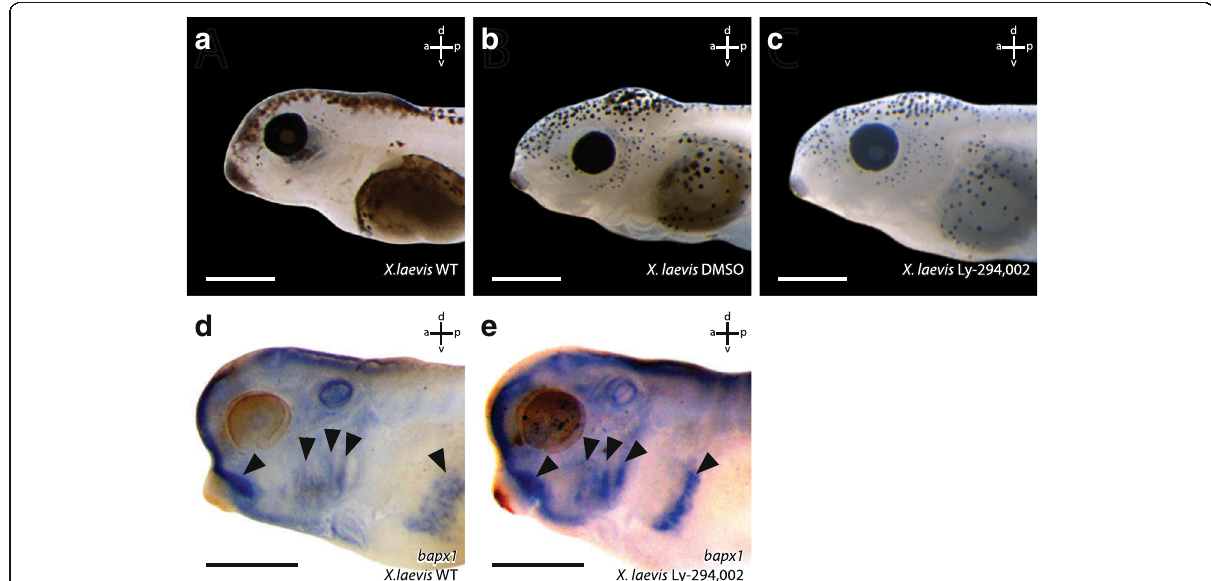
Fig. 2 Effects of Ly-294,002 treatment on external head morphology and bapx1 expression in X. laevis . Lateral view of larvae at NF 44 after rearing in a 0,1× MBS as control, b 0,1 μ M DMSO and c 20 μ M Ly-294,002 from NF 29 onwards. No significant differences in the external morphology can be observed. In situ hybridisation of NF 37 X. laevis larvae raised in d 0,1xMBS as control and e 20 μ M Ly-294,002 from NF 29 onwards in lateral view reveal differences in the expression of bapx1 in the mandibular arch. After bapx1 upregulation the mandibular arch expression domain is broader and extends postero-dorsally. Scale bar 500 μ